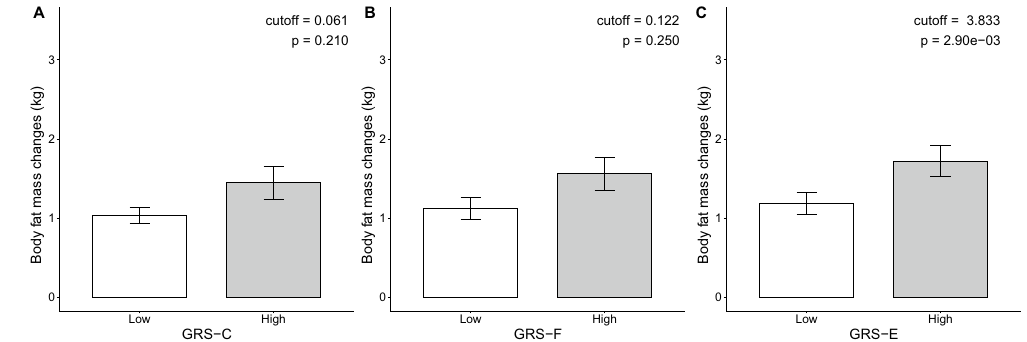
Figure 3. Comparison of the BFM changes between the high and low GRS groups. BFM changes are compared between high and low GRS for each category (GRS-C, GRS-F, and GRS-E). We performed a t-test to compare the mean BFM changes.